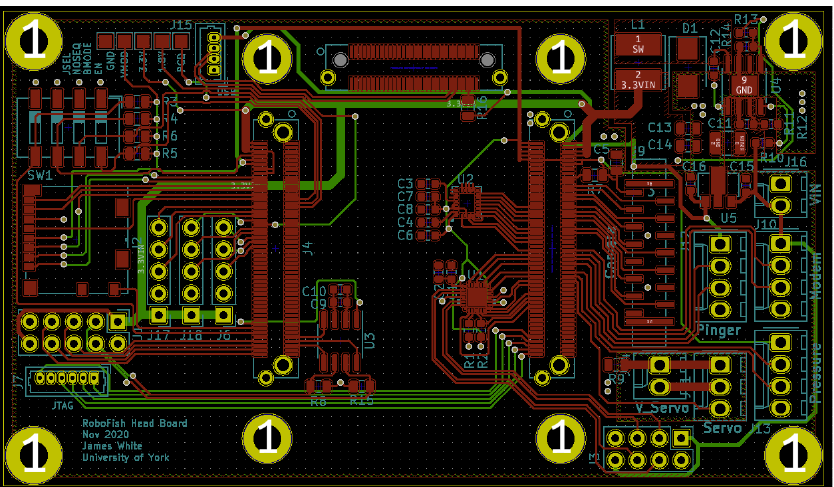
Figure 9. RoboFish Carrier Head board: a carrier PCB designed to contain all of the necessary hardware for interfacing the TE0720 SoM with the rest of RoboFish, programming the SoM and Regulating DC supplies. Either MIPI CSI-2 connector and USB is used for camera interfacing. SD card slot is provided. Either CAN or Ethernet is used for communication; LSM9DS1 IMU is used to provide orientation awareness.